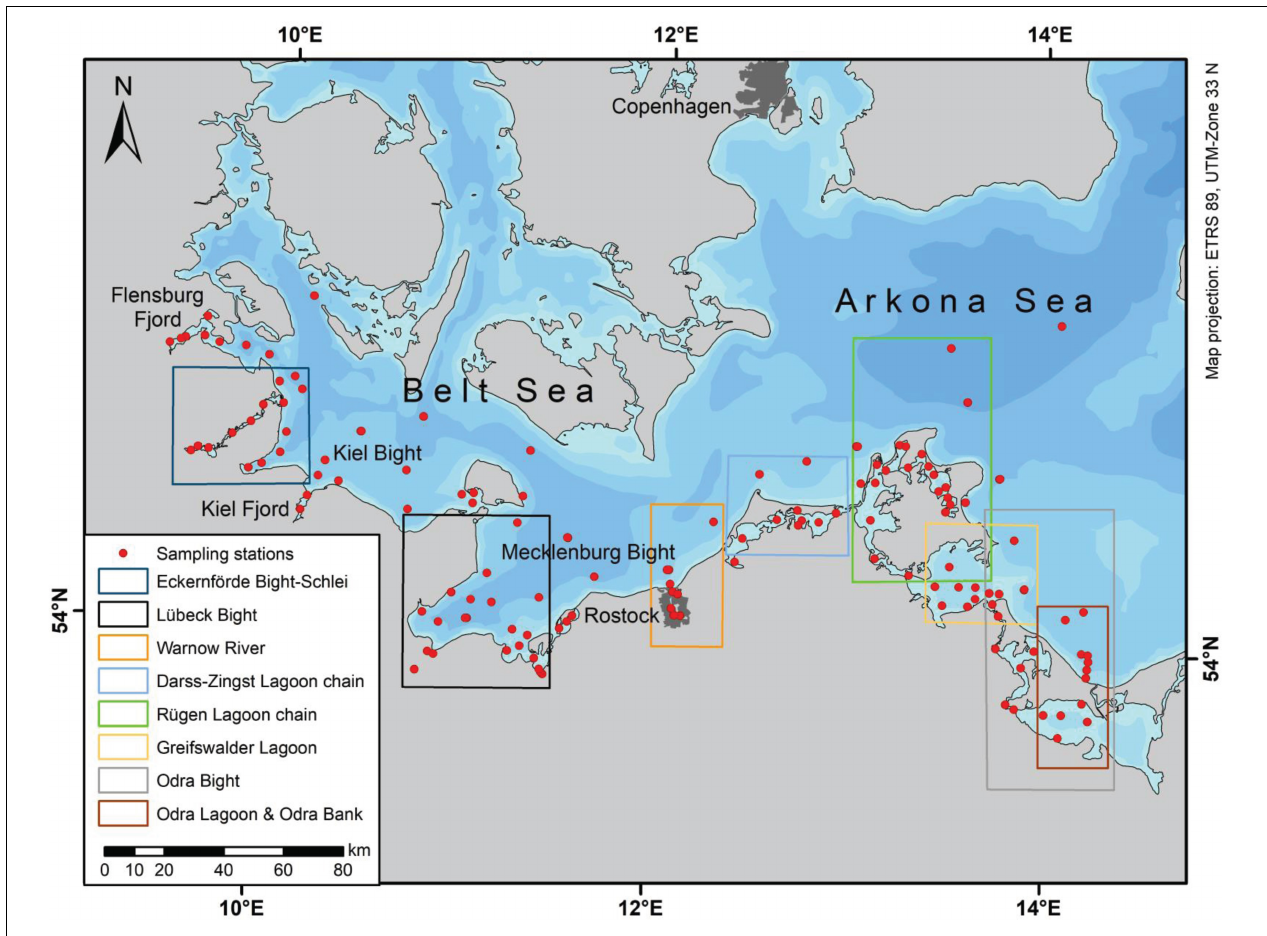
FIGURE 1 | Map of the study area with stations monitored by the LLUR, IOW, and LUNG used in the study; the analyzed regions are indicated in the map by frames or by